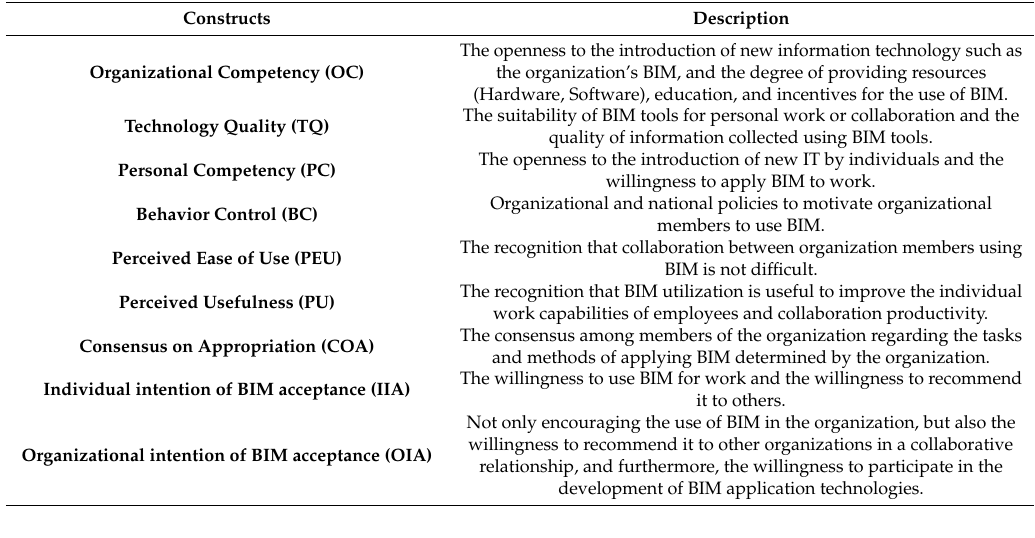
Table 1. The definition of constructs in the BIM acceptance model.